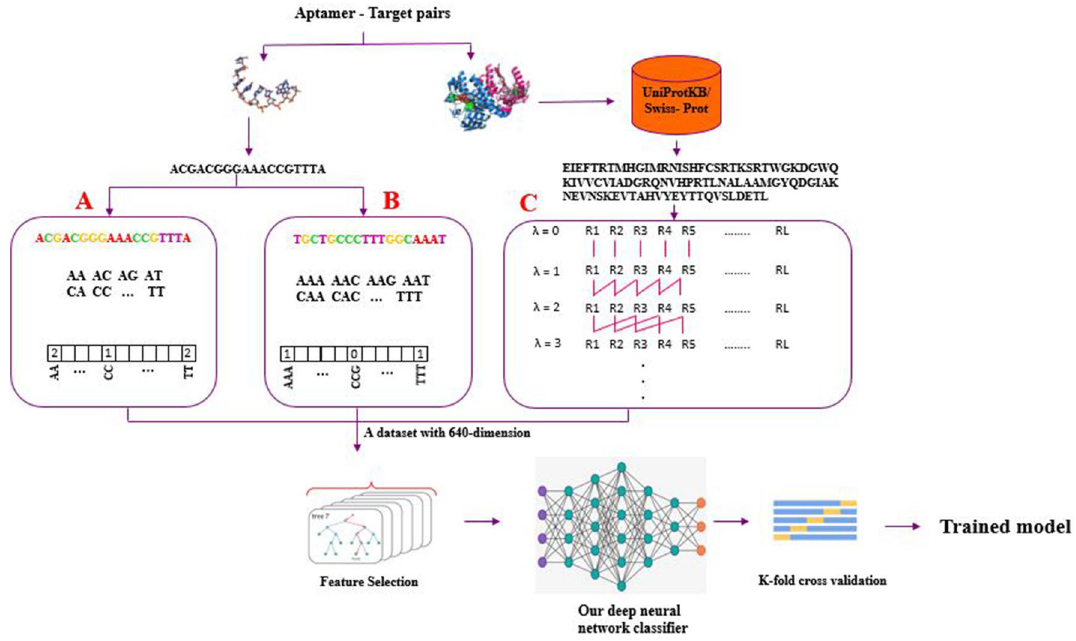
Figure 5. A schematic overview of the training module of AptaNet. For a given sequence (A) Shows K-mer frequency strategy for aptamer encoding; (B) depicts Reverse compliment k-mer strategy for aptamer encoding and (C) Displays Pseudo-Amino Acid Composition strategy for protein encoding. The figure is drawn by using of Microsoft PowerPoint 2016 that is available in https ://www.offic